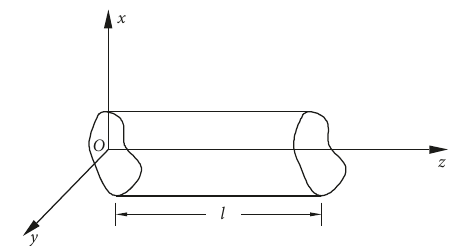
Figure 2: Schematic diagram of the cylindrical